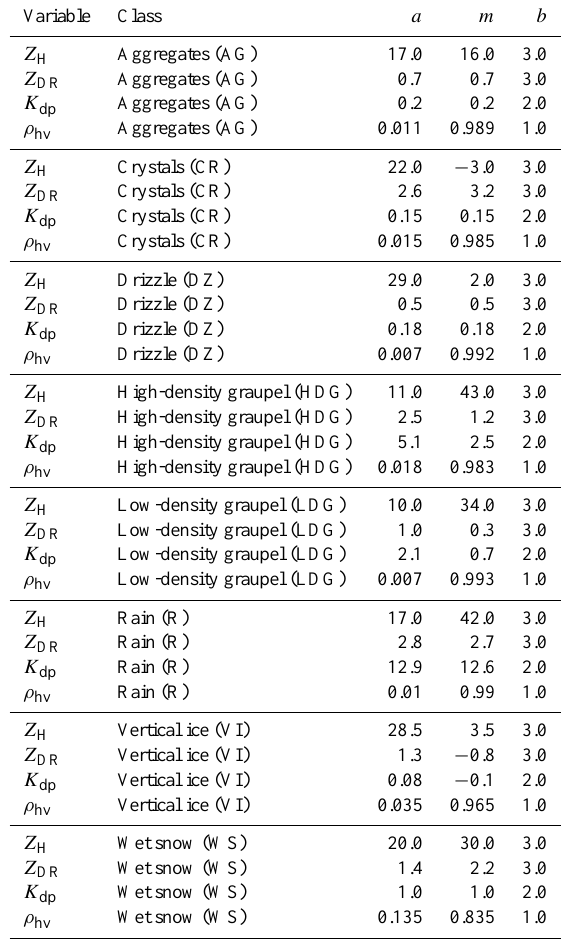
Table B1. Parameters of the membership beta functions β employed in the DR2009 algorithm: midpoint m , width a , and slope b for the available hydrometeor